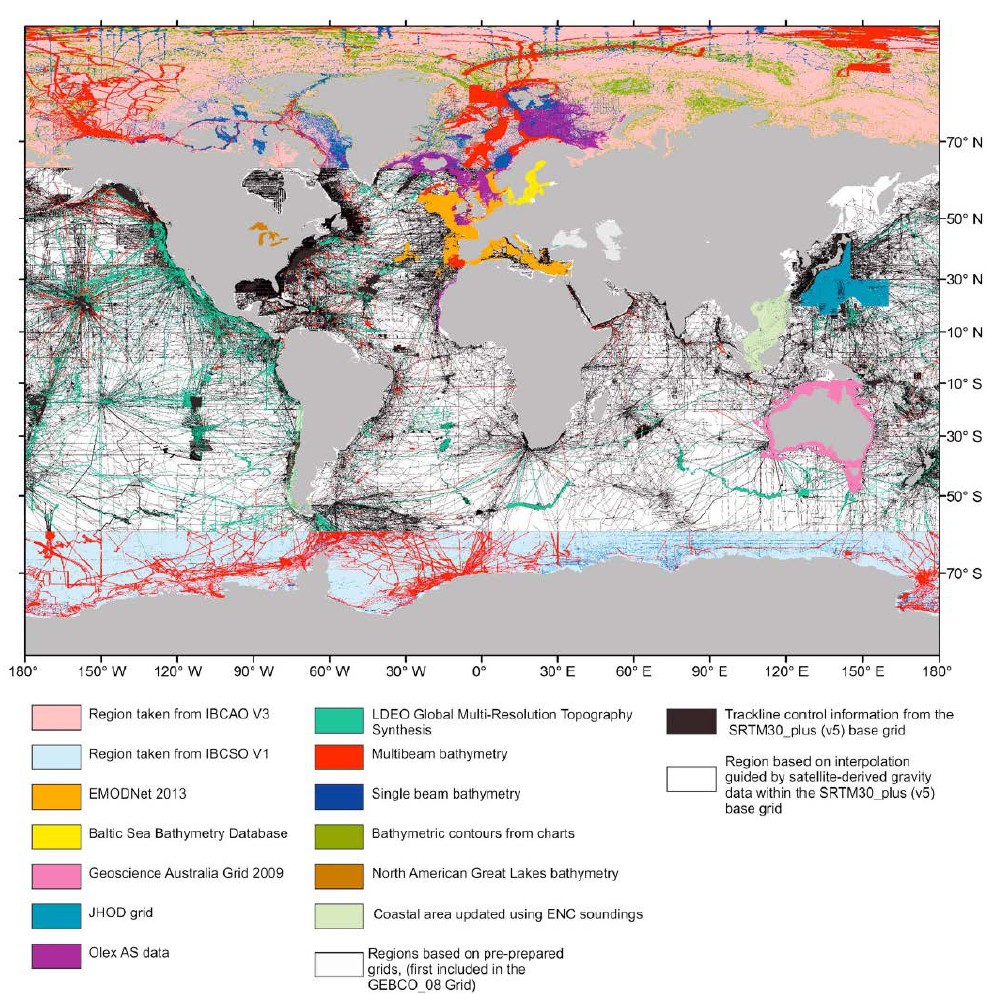
Figure 3. GEBCO_2014 bathymetric data coverage. At this scale, the World Ocean appears much better covered with ship soundings than it is. The fact is that the available bathymetric data used to compile GEBCO_2014 provided depth control points to only 18% of all the 30 arc-second (926 m at the equator) grid cells. Figure is from [1].